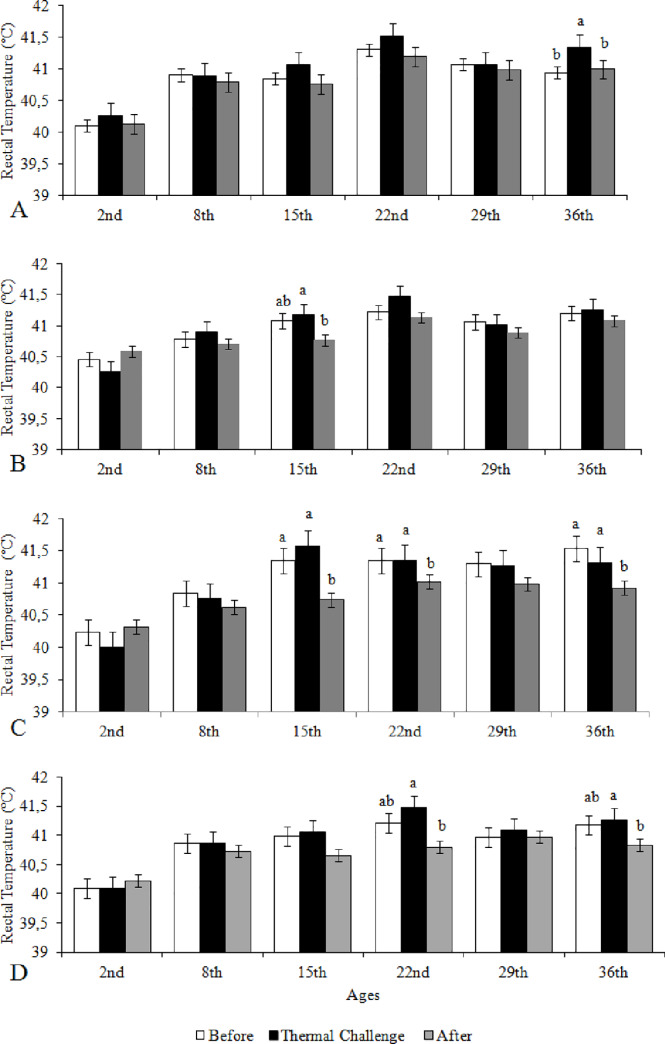
Rectal temperature of broilers from eggs incubated at 37.5°C (A,B) and 39°C (C, D) with Long-Short (A, C) and Short-Long (B, D) hatching pattern, obtained at the preferred temperature before thermal challenge, at thermal challenge (5°C above thermal preference for 45 min), and upon return to thermal preference after thermal challenge, according to age. Short-Long and Long-Short: time intervals between pippings and between external pipping and hatching (2–8,2+20-26h and 11–18+6-10h, respectively). a-b: means with similar letters do not differ from each other by Tukey test (P ≤ 0.05).